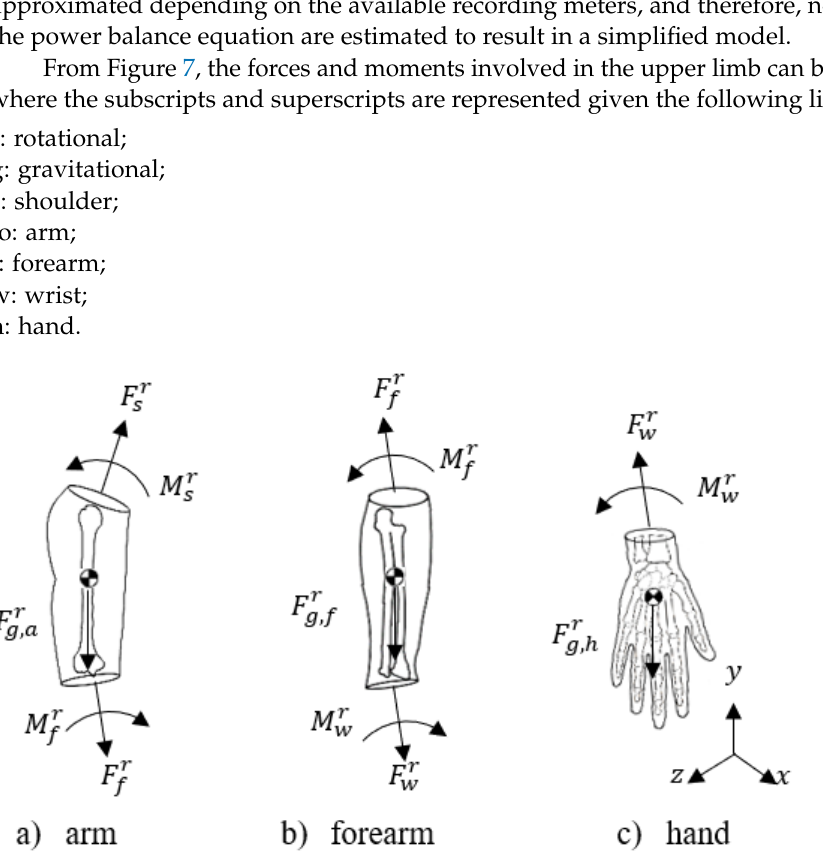
Figure 7. Free-body diagram of a rigid segment model of the right upper limb.